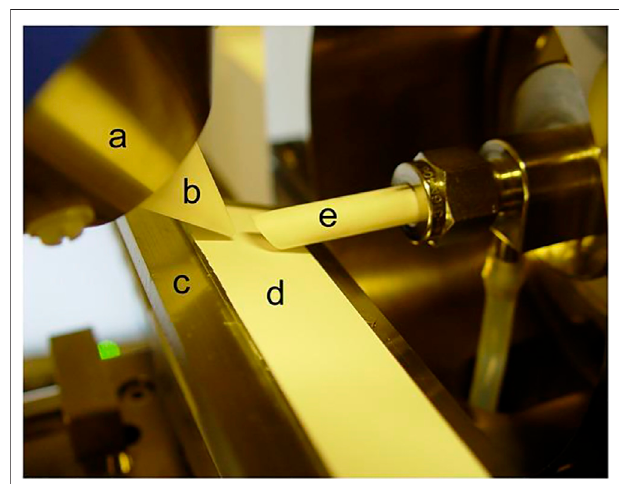
FIGURE 6 | DART ion source with possibility to change the gas fl ow angle for desorption/ionization of analytes from TLC plates. Reprinted with permission from Häbe and Morlock (2015). Copyright © 2015 John Wiley & Sons,